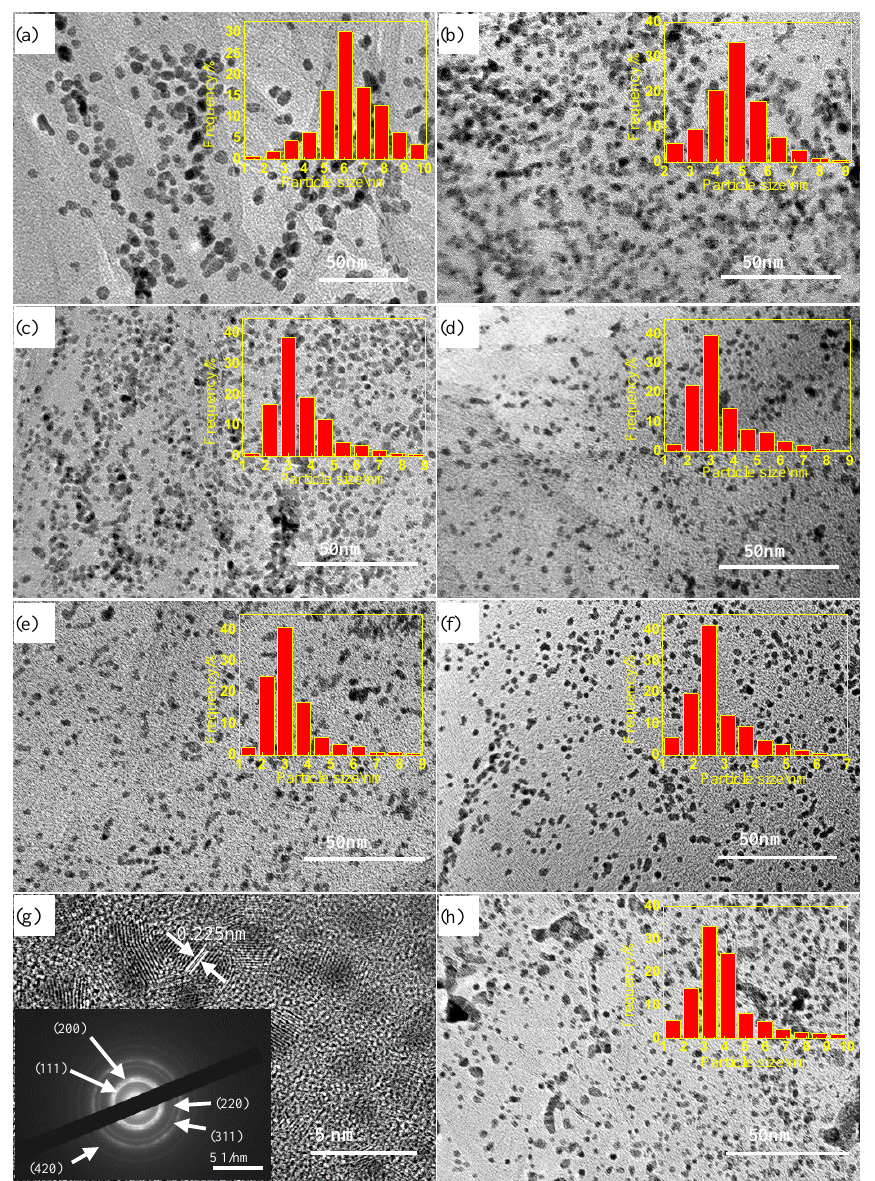
Figure 1. TEM images of catalyst samples with insets showing the particle size distribution histograms: ( a ) 1#; ( b ) 2#; ( c ) 3#; ( d ) 4#; ( e ) 5#; ( f ) 6#; ( h ) 7#; ( g ) high-resolution TEM image of 6# with inset showing the electron diffraction pattern of the selected area.